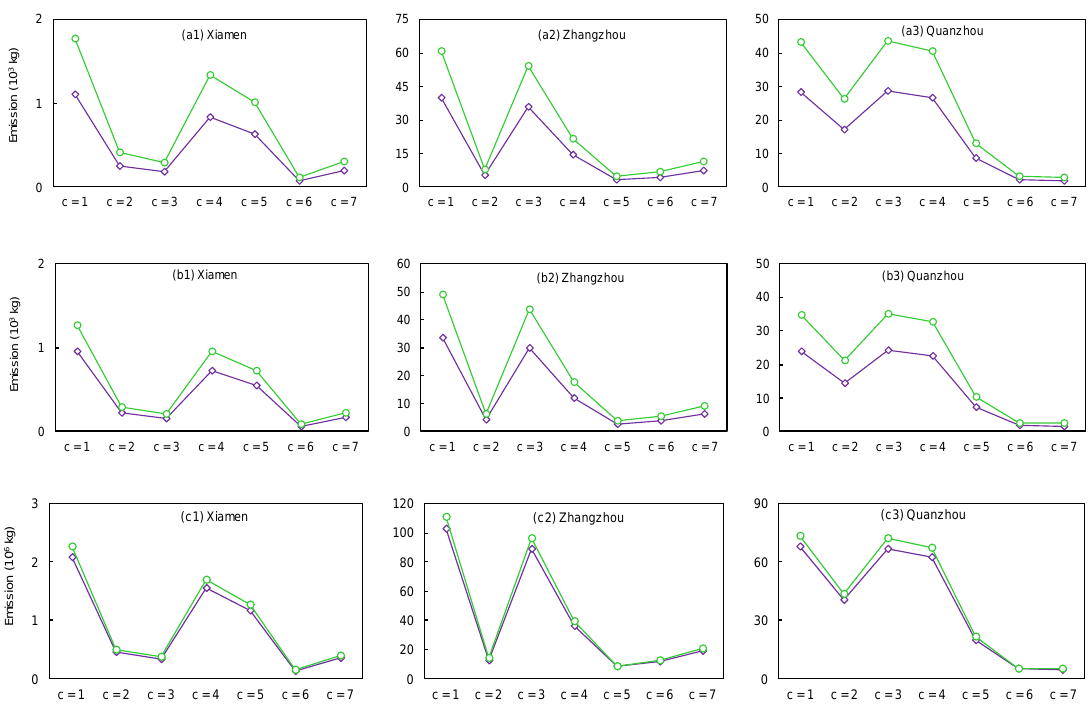
Figure 9. Carbon and effluent emissions: ( a1 ) TN emission in Xiamen, ( a2 ) TN emission in Zhangzhou, ( a3 ) TN emission in Quanzhou, ( b1 ) TP emission in Xiamen, ( b2 ) TP emission in Zhangzhou, ( b3 ) TP emission in Quanzhou, ( c1 ) CO 2 emission in Xiamen, ( c2 ) CO 2 emission in Zhangzhou, ( c3 ) CO 2 emission in Quanzhou.